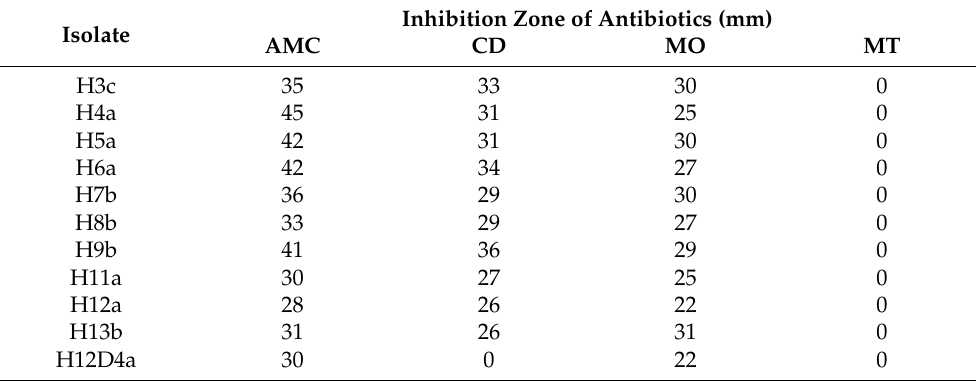
Table 6. The antibiotic sensitivity of Tannerella forsythia